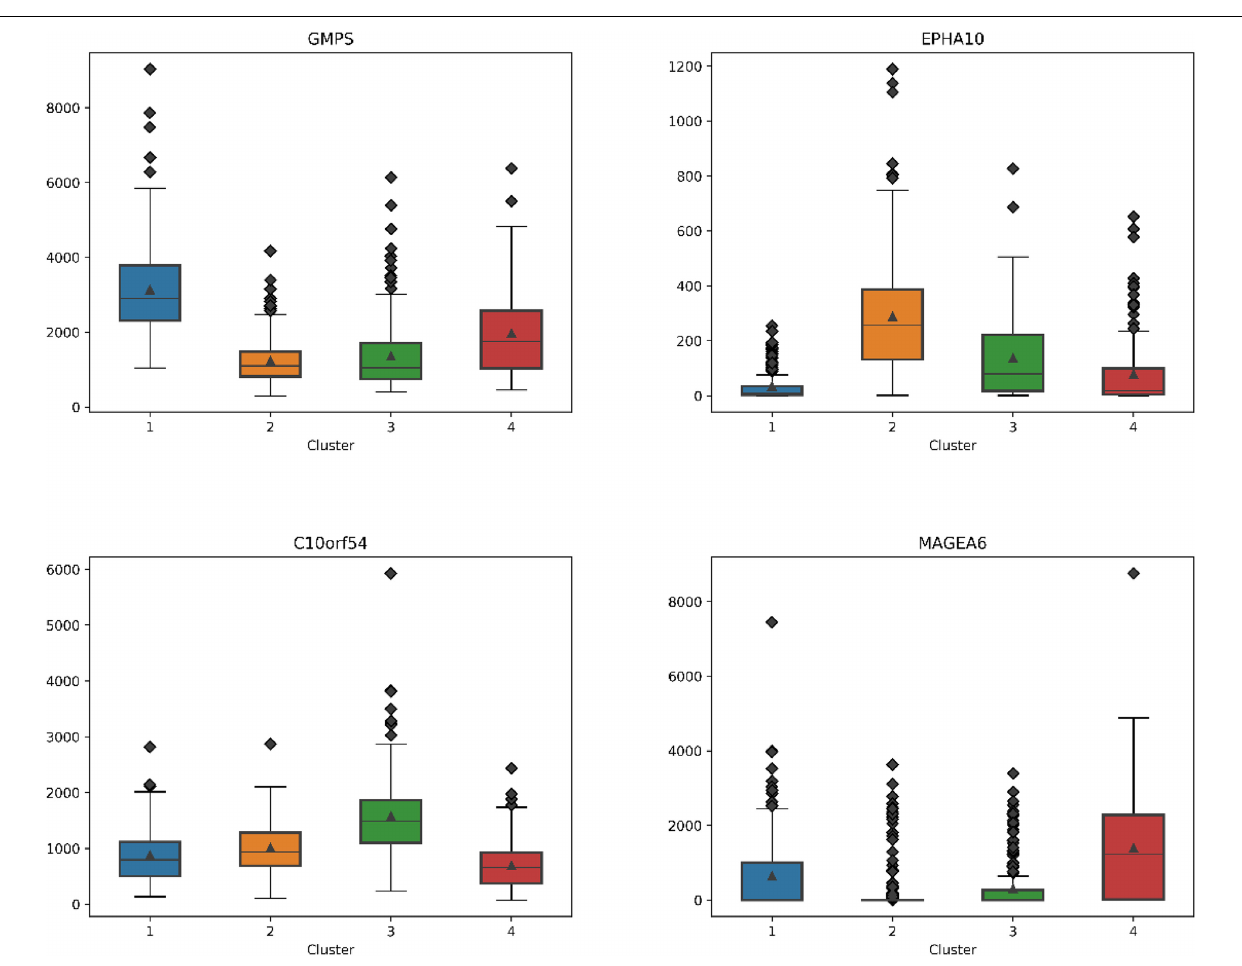
method (Pölsterl et al., 2015, 2016a,b). It includes applying kernel PCA to reduce the original data dimension, using similarity kernel fusion strategy to obtain feature input, and employing spectral clustering as the core clustering method to